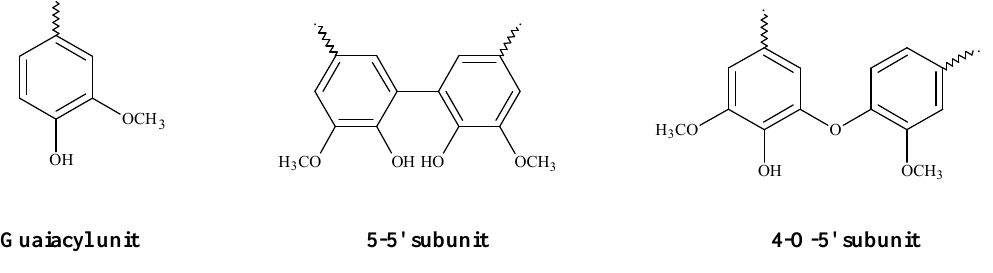
Figure 4. Phenolic subunit detected by 31 P-NMR analysis (guaiacyl, 4- O -5’, 5-5’).